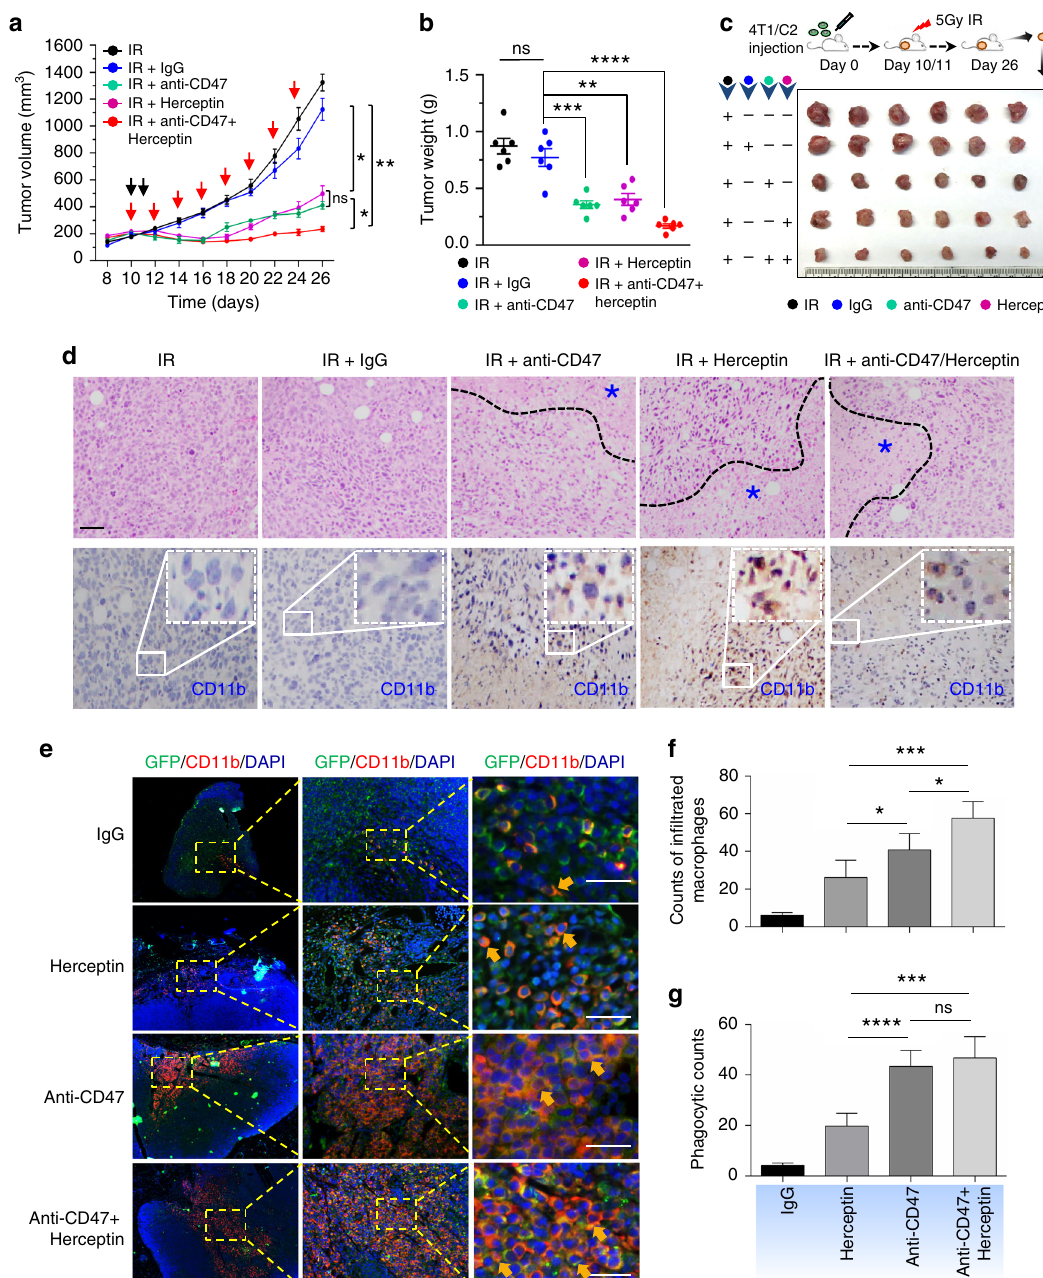
Fig. 6 The synergetic tumor inhibition is enhanced by RT with dual antibody blockage of CD47 and HER2. Tumor volumes ( a ), tumor weights at end of experiments ( b ), and representative images ( c ) were measured with mouse syngeneic breast tumors generated with radioresistant 4T1/C2 cells and treated with intratumoral injection of PBS, IgG, Herceptin (5 mg/kg), anti-CD47 antibody (5 mg/kg), or a combination both antibodies every other day starting at day 10 with radiation delivered locally to tumors of all groups with 5 Gy at days 10 and 11 ( n = 6, mean ± SEM, ns not signi fi cant, * P < 0.05, ** P < 0.01, *** P < 0.001, **** P < 0.0001). d Above, HE staining of 4T1/C2 tumors treated with radiation combined with indicated antibodies. Bottom, representative IHC images of CD11b + macrophages in tumors; scale bar = 100 µ m. e Representative images of in fi ltrated macrophage and macrophage- mediated phagocytosis in the syngeneic mouse orthotopic BC models repeated as in a with GFP-labeled 4T1 tumors detected with indicated antibodies; green, tumor cells; red, in fi ltrated macrophages; blue, cell nucleus stained with DAPI; yellow (indicated with arrows), macrophage-mediated phagocytosis with tumor cells. f Quantitation of relative richness of in fi ltrated CD11b + macrophages. g Quantitation of macrophages-mediated phagocytosis with tumor cells counted in multiple areas in the high-power fi elds marked with yellow arrows (Image Pro Plus 6.0; b , c , * P < 0.05, **** P < 0.0001; ns not signi fi